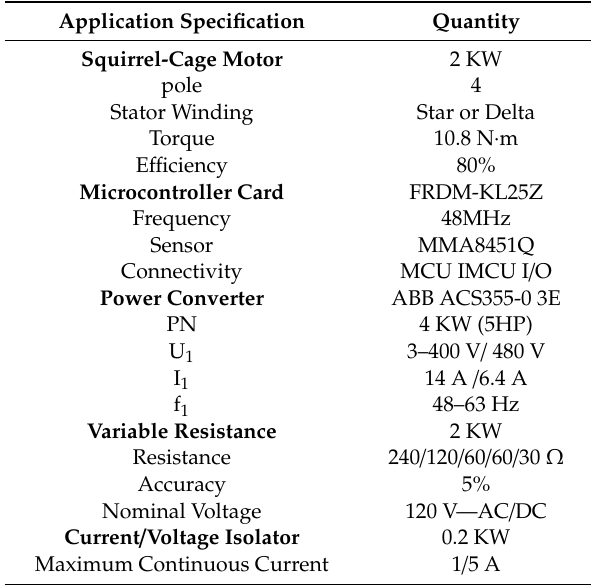
Figure 9. Hardware implementation. Table 2. Parameters of variable speed induction motor.